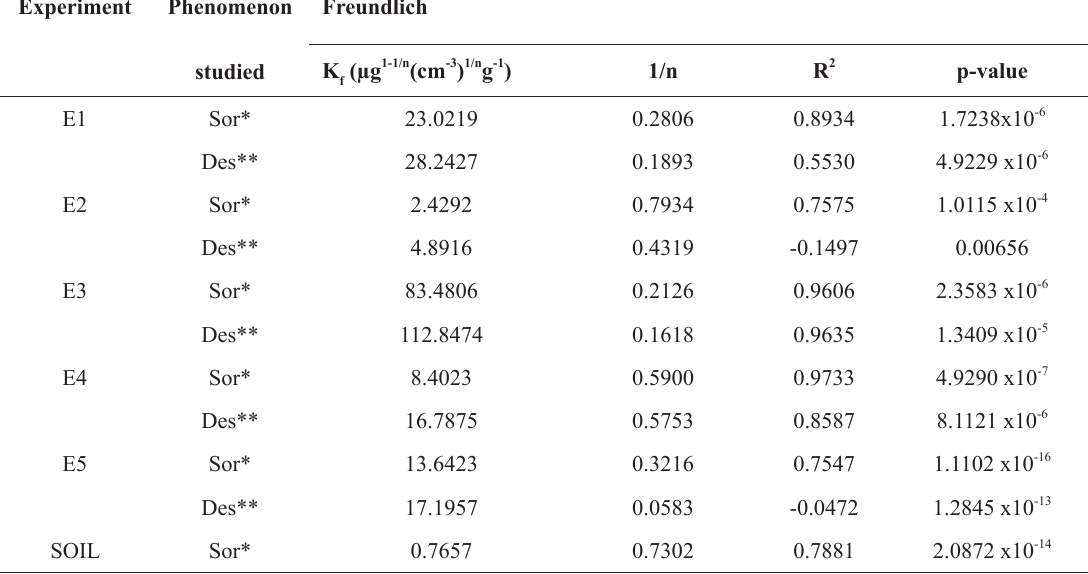
and 1/n) and its coefficients of f